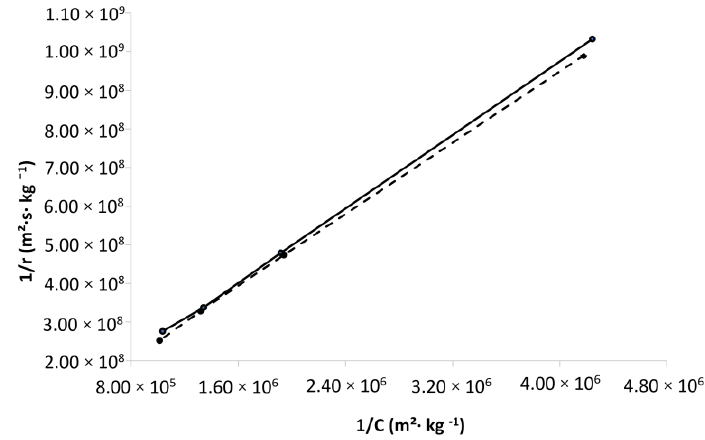
Table 2. Experimentally estimated kinetic parameters k´ and K p.